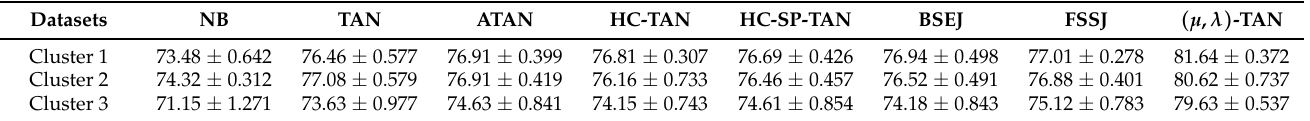
Table 2. Performance comparison of NB, TAN, ATAN, HC-TAN, HC-SP-TAN, BSEJ, FSSJ, and ( µ , λ ) -TAN in terms of accuracy in the test